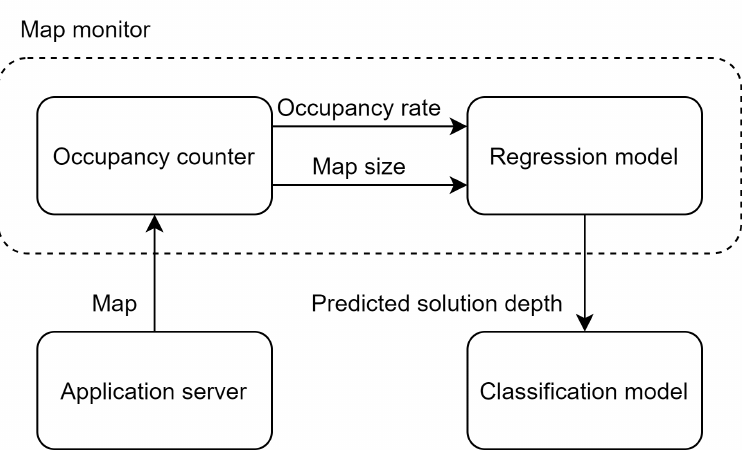
Figure 9. Detailed architecture of the map monitoring